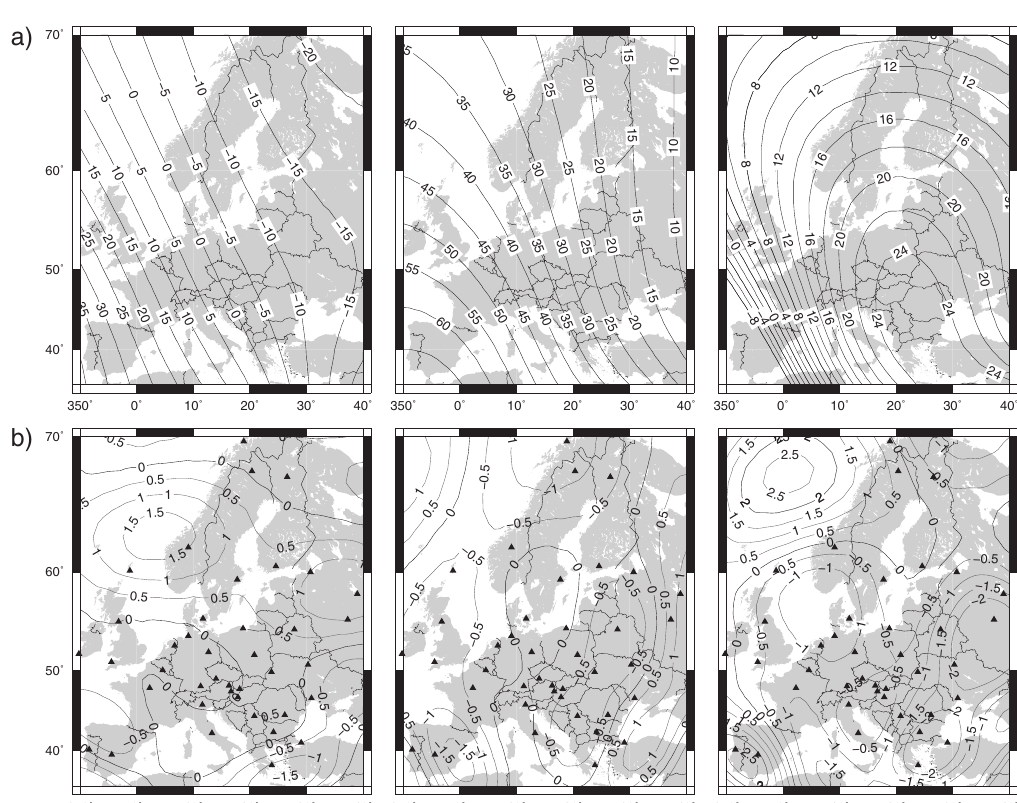
Fig. 4a-b. Maps of the X (left), Y (center) and Z (right) secular variation components at epoch 1980.5 obtained from the CM4 model (top). Maps of differences between EU_MIX and CM4 models, (EU_MIX- CM4), are al- so shown (bottom). Units nTyr –1 . Mercator map